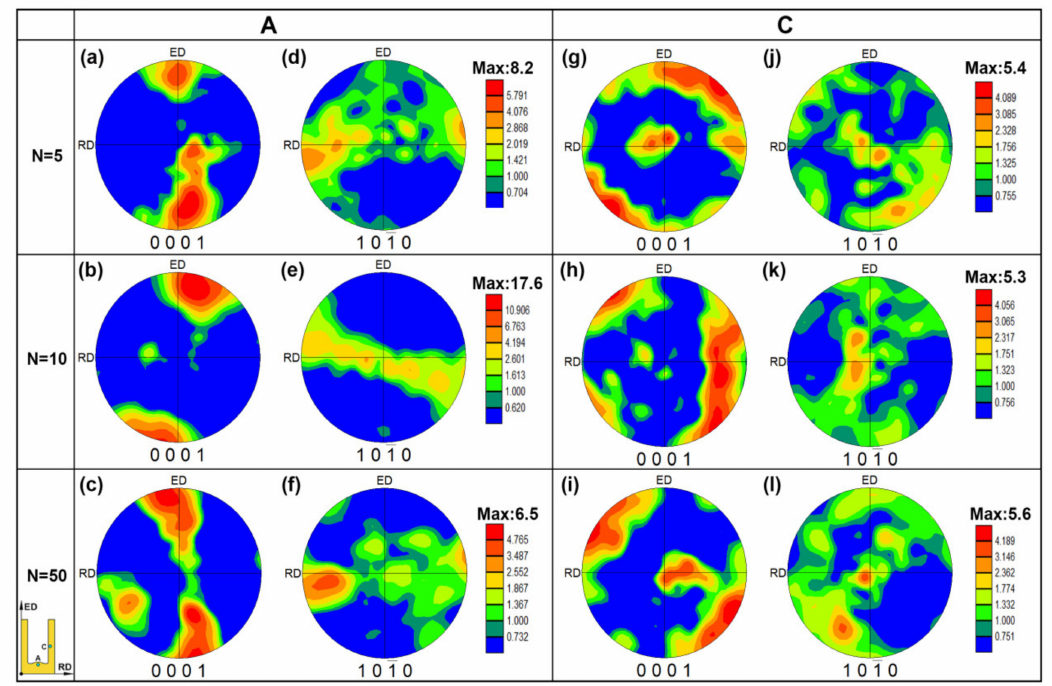
Figure 8. Texture development during the RBE process: ( a – c , g – i ) (0001) pole figures (PF) and ( d – f , j – l ) (10-10) pole figures